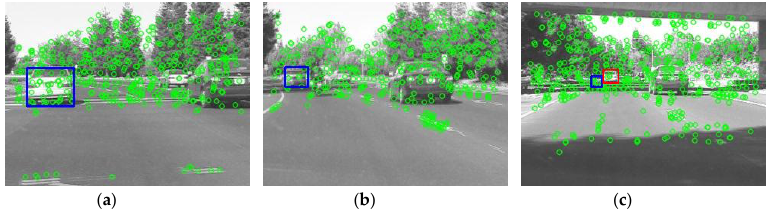
Figure 4. As the size of a target object (white car on the left) shrinks, the target could be erroneously tracked; ( a ) target object; ( b ) the target object is shrinking; ( c ) the red bounding box indicates the erroneous tracking location.